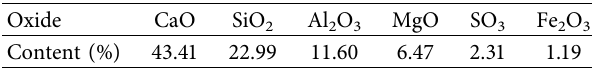
Table 1: Chemical composition of the blast furnace slag (wt%). Oxide CaO SiO